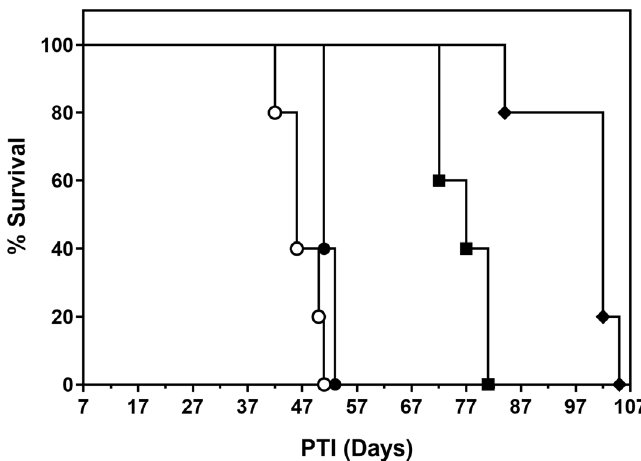
Figure 6. Antitumor efficacy of EC2629 +/− anti-CTLA-4 on FR expressing intraperitoneal ID8-Cl15 tumors in C57BL/6 mice. ID8-Cl15 tumor cells (1 × 10 6 ) were inoculated intraperitoneally into C57BL/6 mice and therapy administered on randomized animals. open circle, untreated controls; filled circle, anti-CTLA-4 antibody 0.25 mg/dose, BIW, 5 doses; filled square, EC2629, 0.1 µmol/kg, BIW × 6 doses; filled diamond, EC2629+ anti- CTLA-4 antibody. N = 5 mice/group.